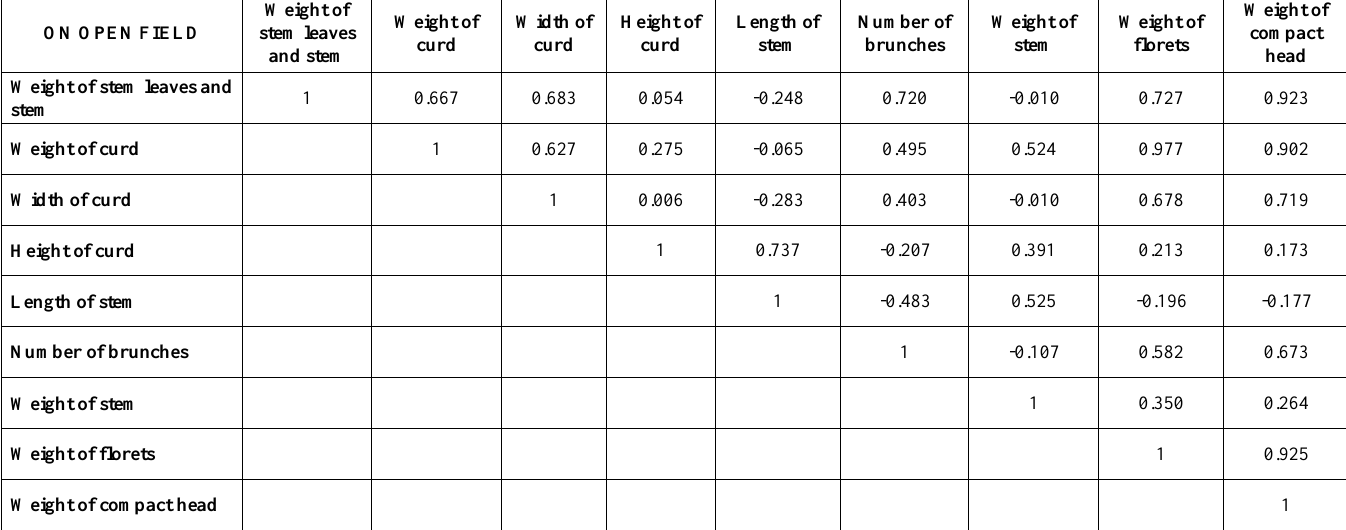
Table 2. Correlation matrix for different quality parameters in the mean of varieties by open field